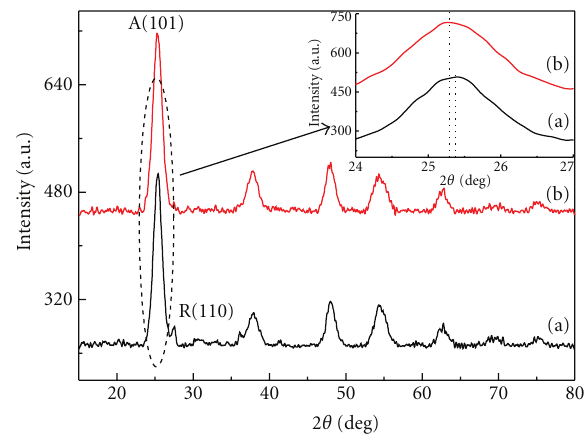
Figure 1: XRD patterns of pure (a) and N-Cl-doped (b) TiO 2